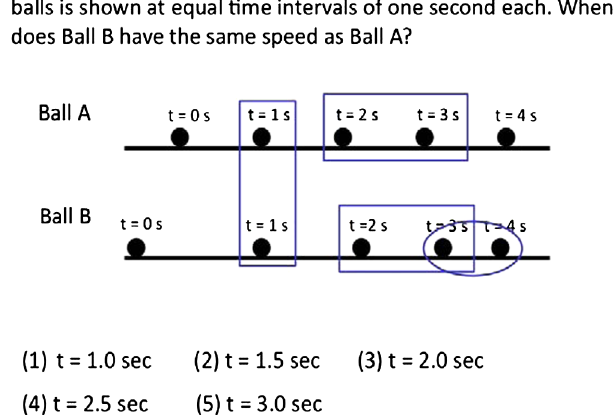
FIG. 2 (color online). Thematically relevant AOI is the dis- tance between balls at 2–3 sec. Novicelike AOI is when the balls are at the same position, at 1 sec. Perceptually salient AOI is oval around ball B at 3 and 4 sec.